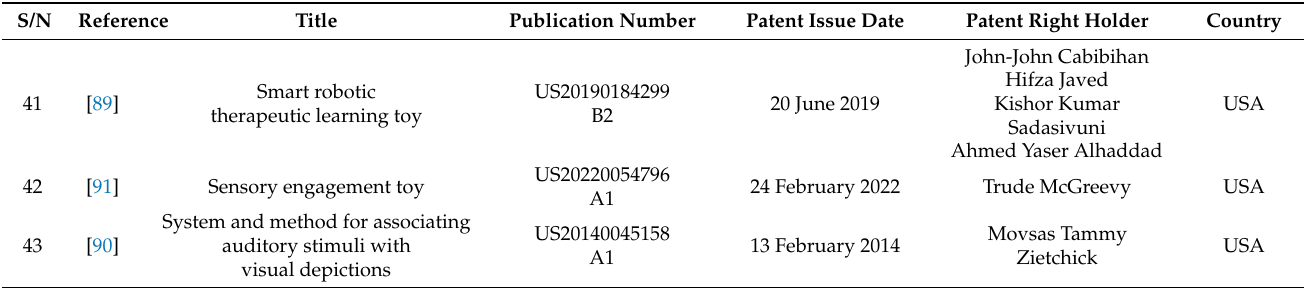
Table 12. Sample of assistive technology patents in the form of